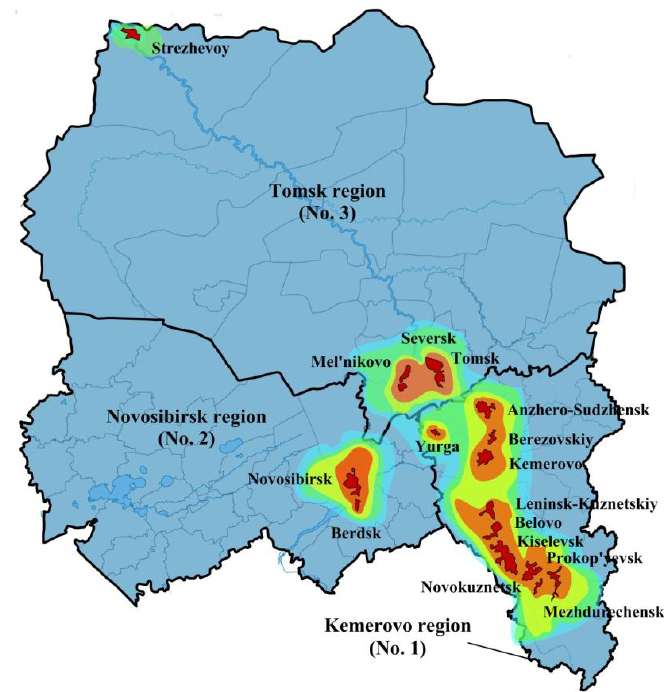
Figure 6. Location of industrial waste and MSW sources [5].